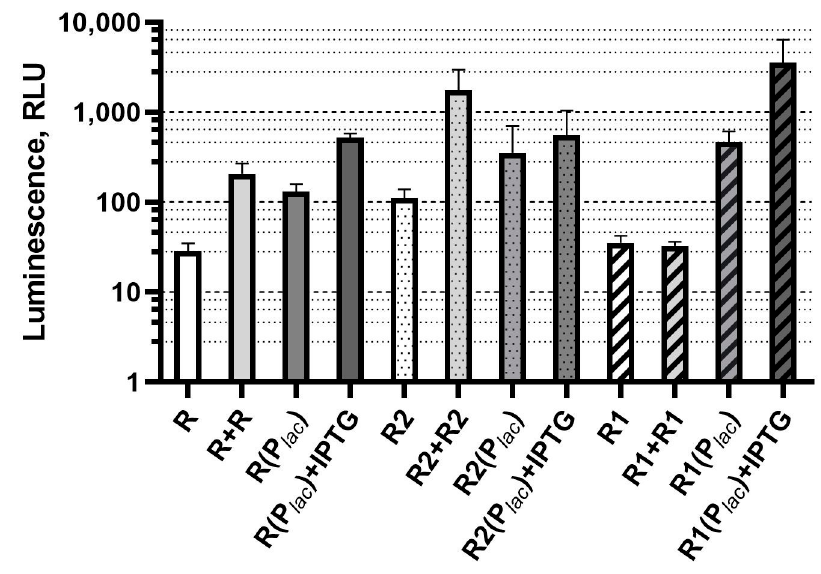
Figure 3. Dependence of base luminescence of LuxR-based biosensors on regulatory gene dosage